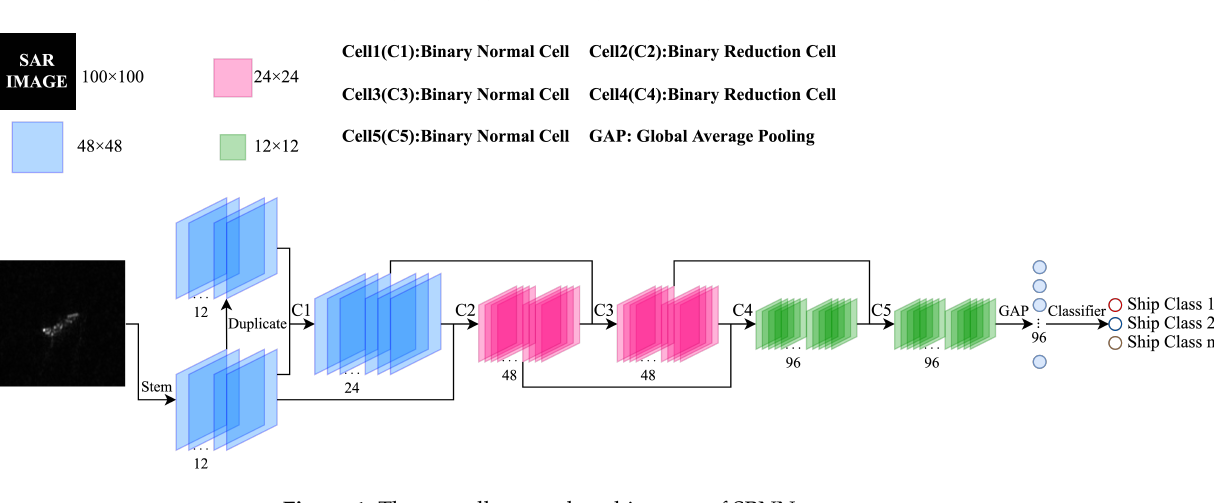
Figure 1. The overall network architecture of